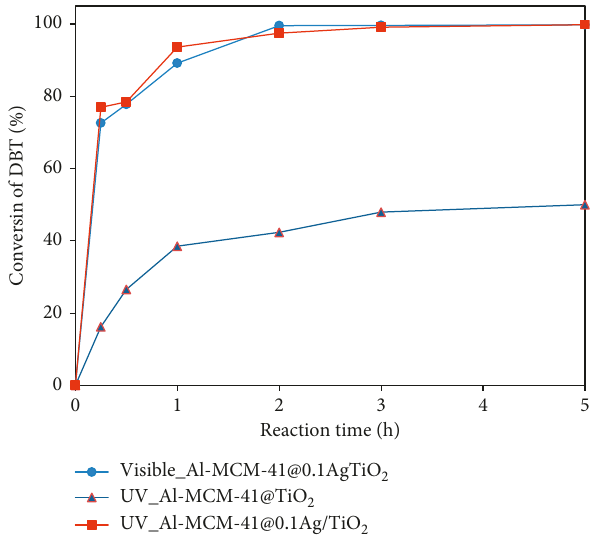
Figure 8: Conversion of DBT over Al-MCM-41@TiO conditions: V (model fuel) � 20mL, m